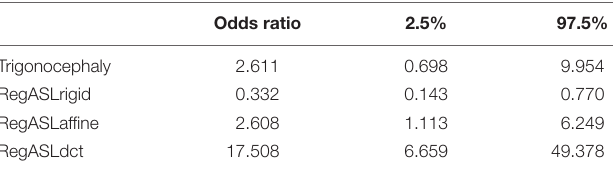
TABLE 2 | Odds ratios for receiving a higher rating [i.e., the odds are calculated as P (rating > k )/ P (rating = k )]. Odds ratio 2.5% 97.5%